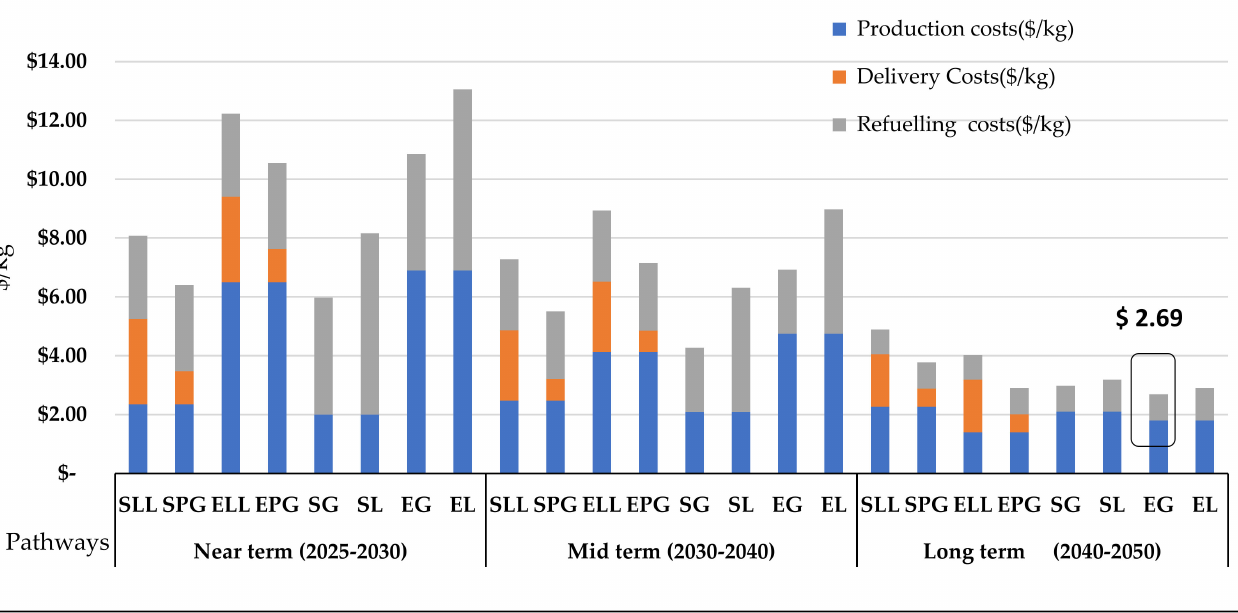
Figure 7. Hydrogen dispensed costs at a 5 tpd refueling station through different